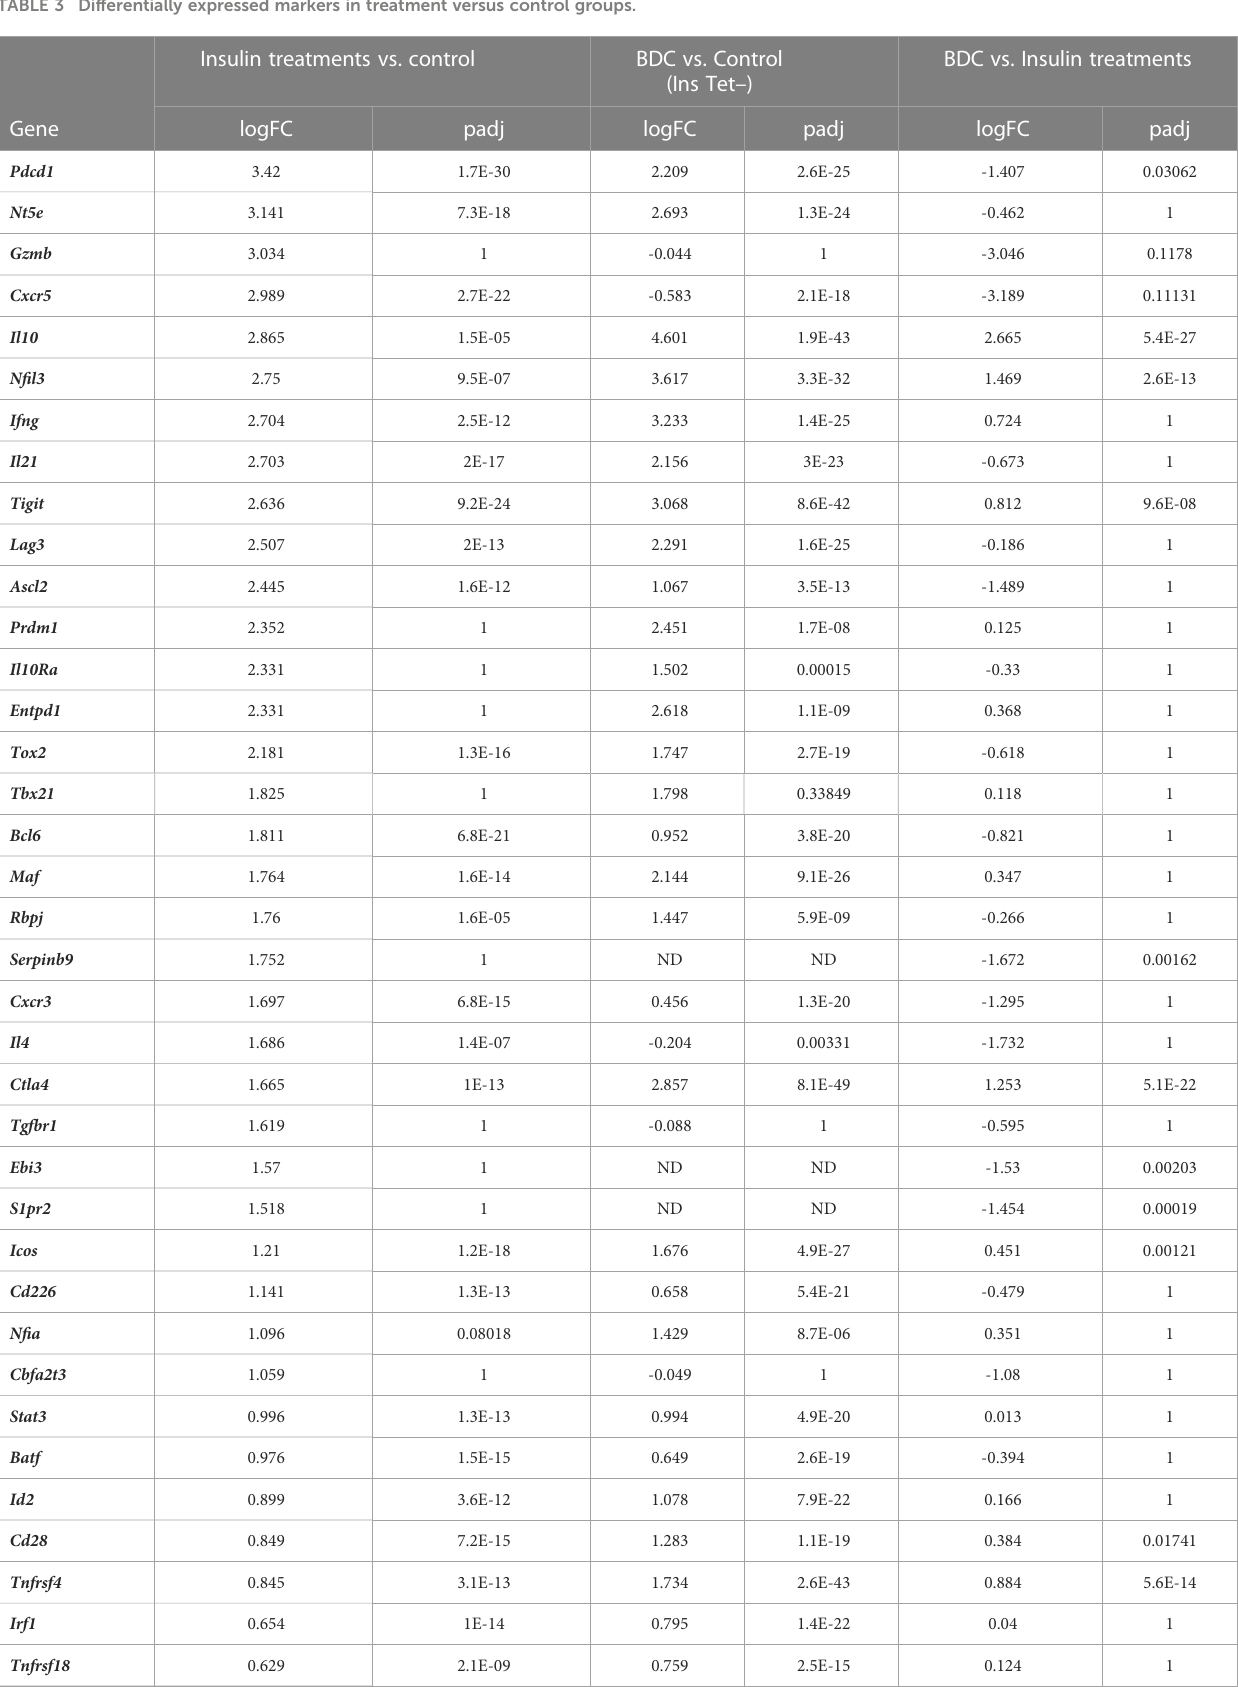
TABLE 3 Differentially expressed markers in treatment versus control groups. Insulin treatments vs.